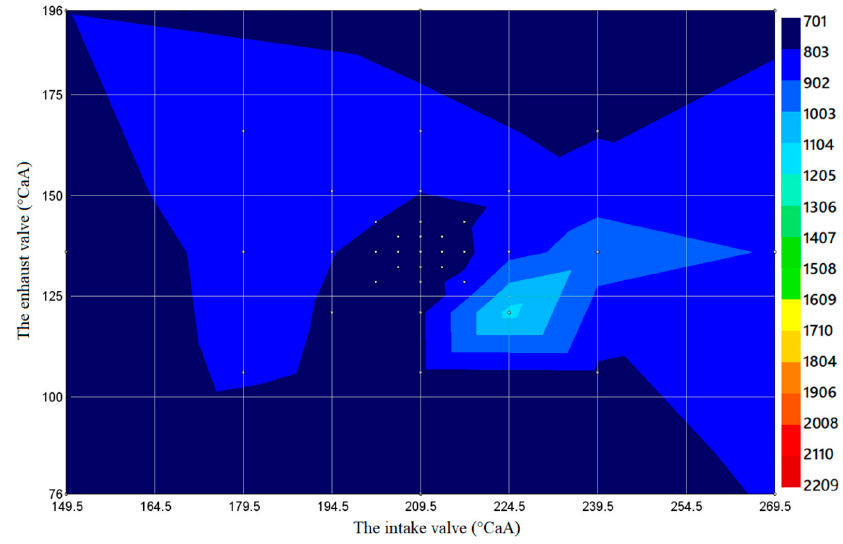
Figure 10. 50% load